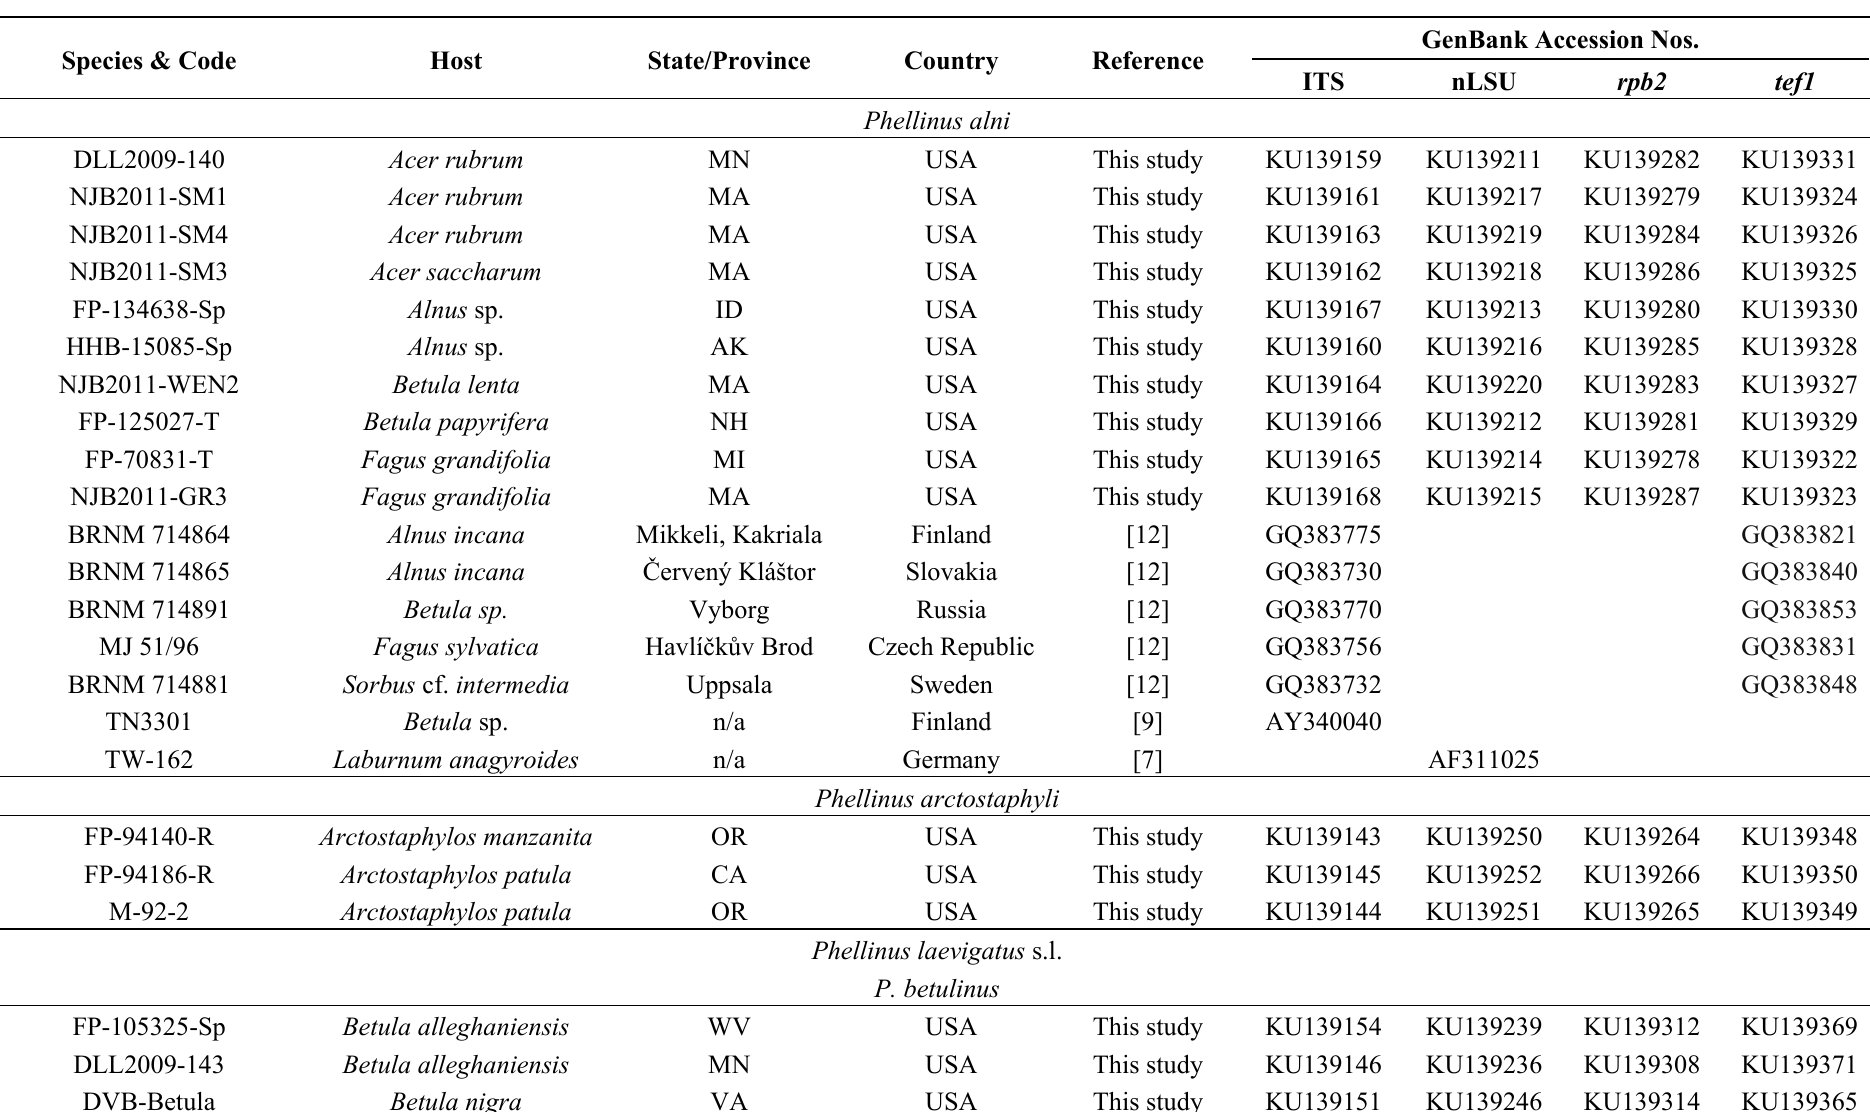
Table 1. Information and GenBank accession numbers for isolates of Phellinus s.s.